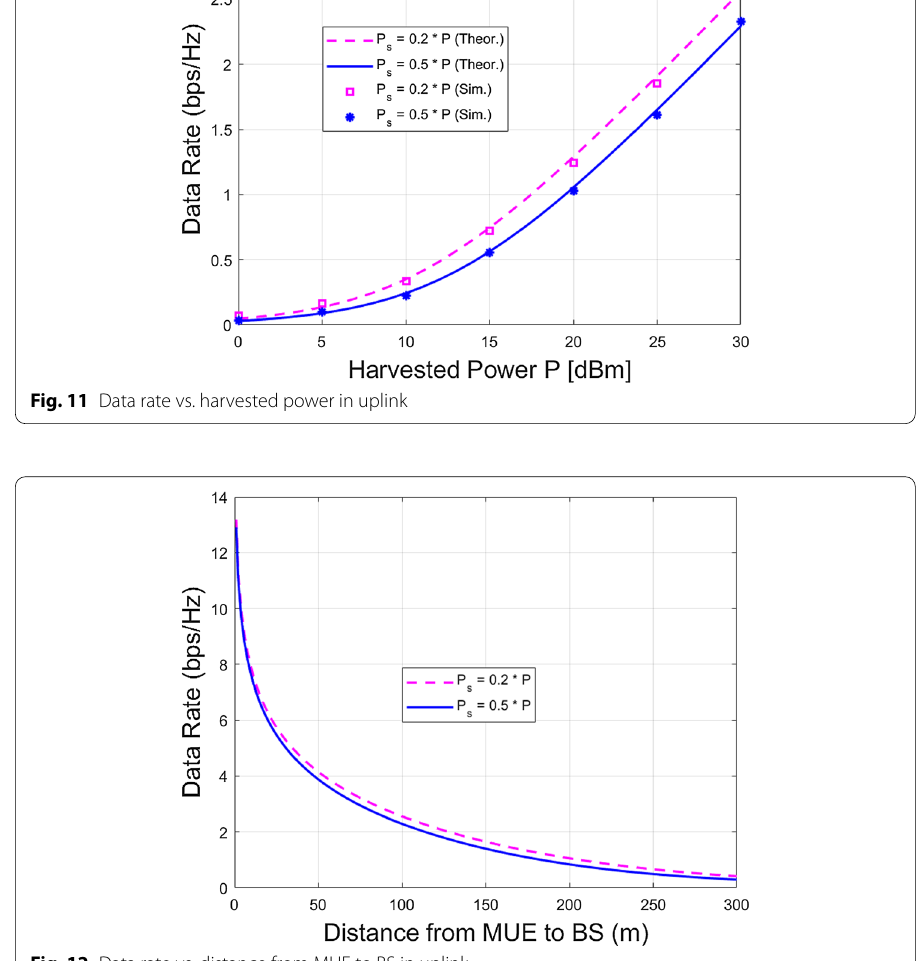
Fig. 12 Data rate vs. distance from MUE to BS in